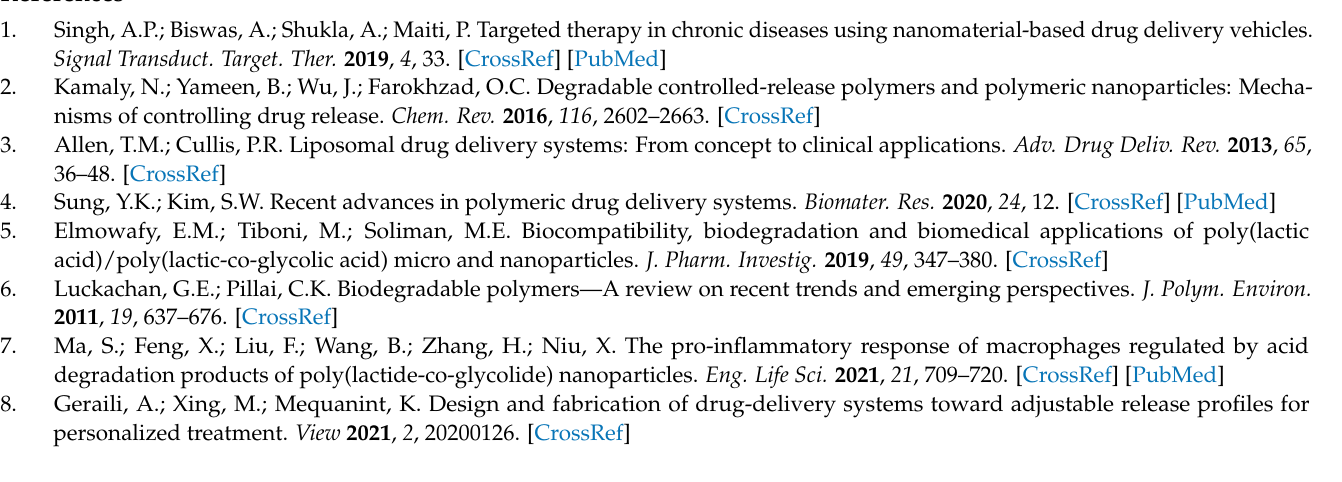
(b) NP2, (c) NP3, (d) NP4; Figure S2a. FT-IR spectra of PLGA and PHA. The major peaks are indicated for each spectrum of PLGA and PHA, respectively; Figure S2b. DSC analysis of PLGA and PHA. The major peaks are indicated for each DSC curve of PLGA and PHA, respectively; Figure S2c. XRD spectrum of PLGA and PHA, respectively; Figure S3. Storage stability of NPs in saline (a,b) and 10% fetal bovine serum-containing saline (c,d) at 4 ◦ C for 1 week. Both size and zeta potential ( ζ ) values of NPs were monitored: (a) changes of size in saline, (b) changes of zeta potential values in saline, (c) changes of size of NPs in 10% fetal bovine serum-containing saline, (d) changes of zeta potential values in 10% fetal bovine serum-containing saline; Figure S4. PTX release data fitted to various kinetic models (zero-order, first-order, Higuchi, and Hixson-Crowell) of NPs obtained